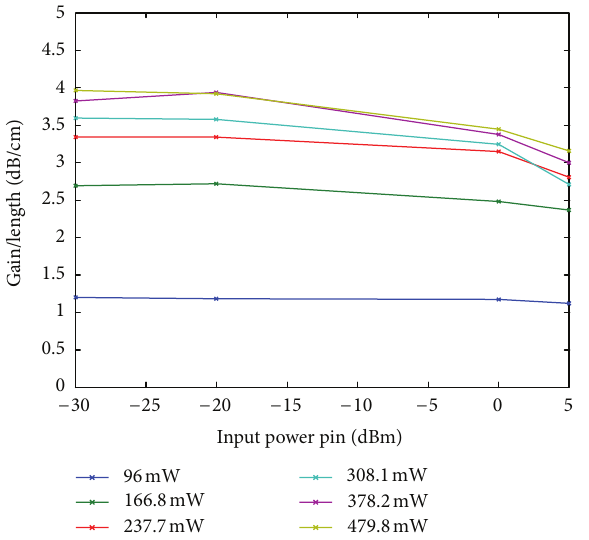
Figure 6: Internal gain per unit length as a function of the input power level at 1535 nm. The amplifier shows some degree of